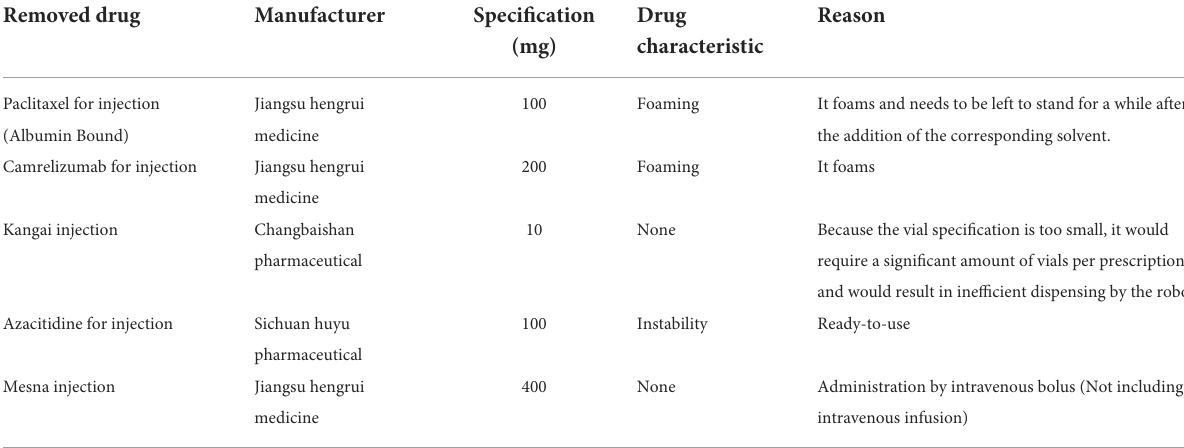
TABLE 1 Drugs not considered for vial sharing by intelligent dispensing robots. Removed drug Manufacturer